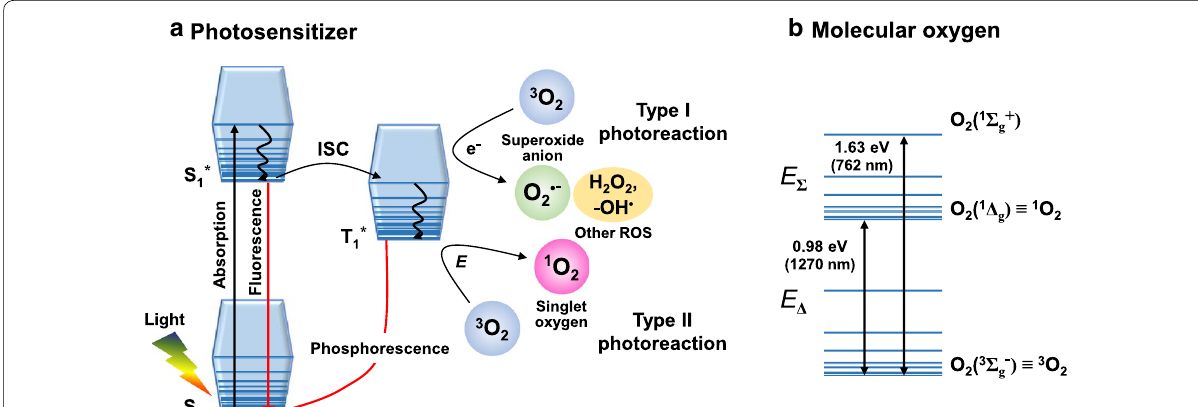
Fig. 2 Jablonski diagram of photosensitizer and molecular oxygen (O 2 ). a Photosensitization with the singlet ground (S 0 ) and excited (S 1* ) states and their further interactions with O 2 . The triplet excited state (T 1* ) through an intersystem crossing (ISC) process can undergo electron (e − ) transfer to the ground state of molecular oxygen O 2 ( 3 Σ g − ) (i.e. 3 O 2 ), generating superoxide anion (O 2• ‒ ) and other ROS products (e.g. H 2 O 2 and –OH • ) as Type I photoreaction. In addition, T 1* can undergo energy ( E ) transfer to 3 O 2 , producing highly cytotoxic O 2 ( 1 Δ g ), commonly known as singlet oxygen ( 1 O 2 ), as Type II photoreaction. b Electronic configuration of the triplet ground state molecular oxygen O 2 ( 3 Σ g − ), its first (i.e. lowest‑energy) singlet excited state O 2 ( 1 Δ g ), and its second (higher energy) singlet excited state O 2 ( 1 Σ g + ) [36, 37], where the superscripts 3 and 1 indicate triplet and singlet states, respectively. The energy gaps between the ground state and the two singlet excited states are shown in eV, including the corresponding lumines‑ cent